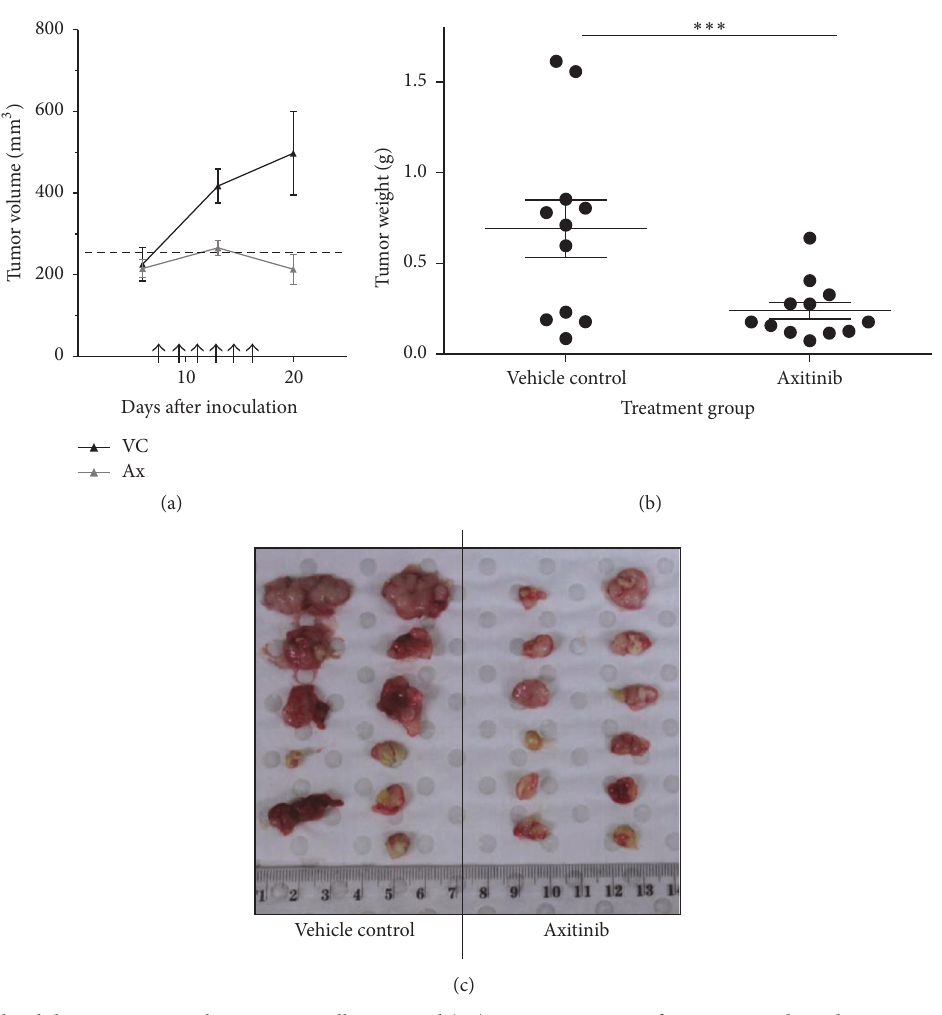
Figure 6: Axitinib inhibits tumor growth in vivo . Serially passaged (P5) MLS 1765 xenografts were transplanted into new NOD-SCID mice. Whentumorsreachedapproximately200 mm 3 ,micewereinjectedwith30 mg/kgaxitiniborvehiclecontrol(sixmicepergroup)everysecond day for 12 days (day 7 to 18 after inoculation), as indicated by arrows and tumor size measured by digital calipers. Differences in tumor size were assessed by paired, two-tailed 𝑡 -test. The data are presented as the mean ± SEM. The dashed line represents the average tumor size when treatment commenced (a). On day 20, mice were culled, and tumors were excised, weighed (b), and photographed (c). Differences in tumor weight were assessed by paired, two-tailed 𝑡 -test. In (b), all individual data are presented, and horizontal lines indicate the mean ± SEM. In (c), all tumors are shown; note that one tumor did not